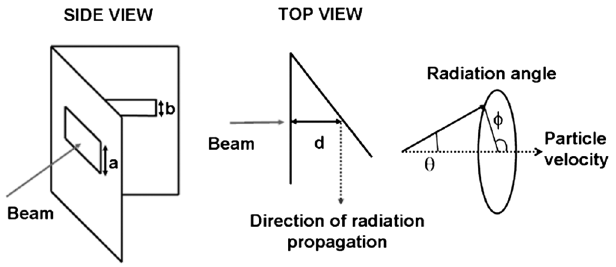
FIG. 1. Sketch of the two-slits setup. Left: side view; center: top view; right: definition of the coordinates system. Dimension a is the aperture size of the first slit, b the size of the second slit, and d the distance between slits